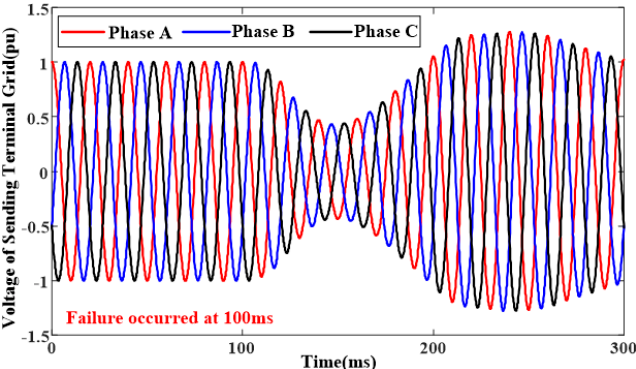
Figure 9. Voltage waveform in 35 kV sending ac grid under commutation failure.